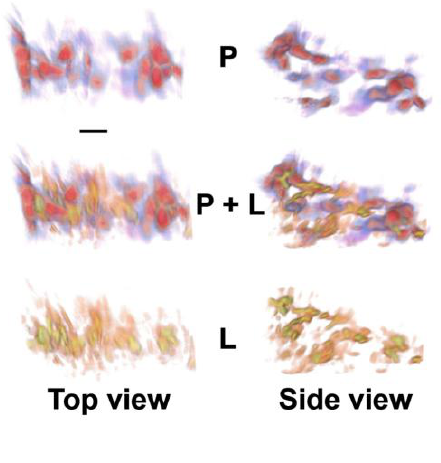
Figure 9. Top and side views of 3D protein and lipid distributions for an embryoid body colony of stem cells. Volume renderings from reconstructions for the protein (P) amide I absorption band [1,650 cm −1 ; blue-red; ( top )] and lipid (L)-specific bands [2,850 cm −1 ; orange-yellow; ( side )] reveal three layers of cell bodies with inhomogeneously distributed lipids. The two spectral region reconstructions are shown independently and superimposed (P + L) to provide context for the images. Scale bar, 10 µm. (Reprinted with permission from [7]. Copyright 2012 American Chemical